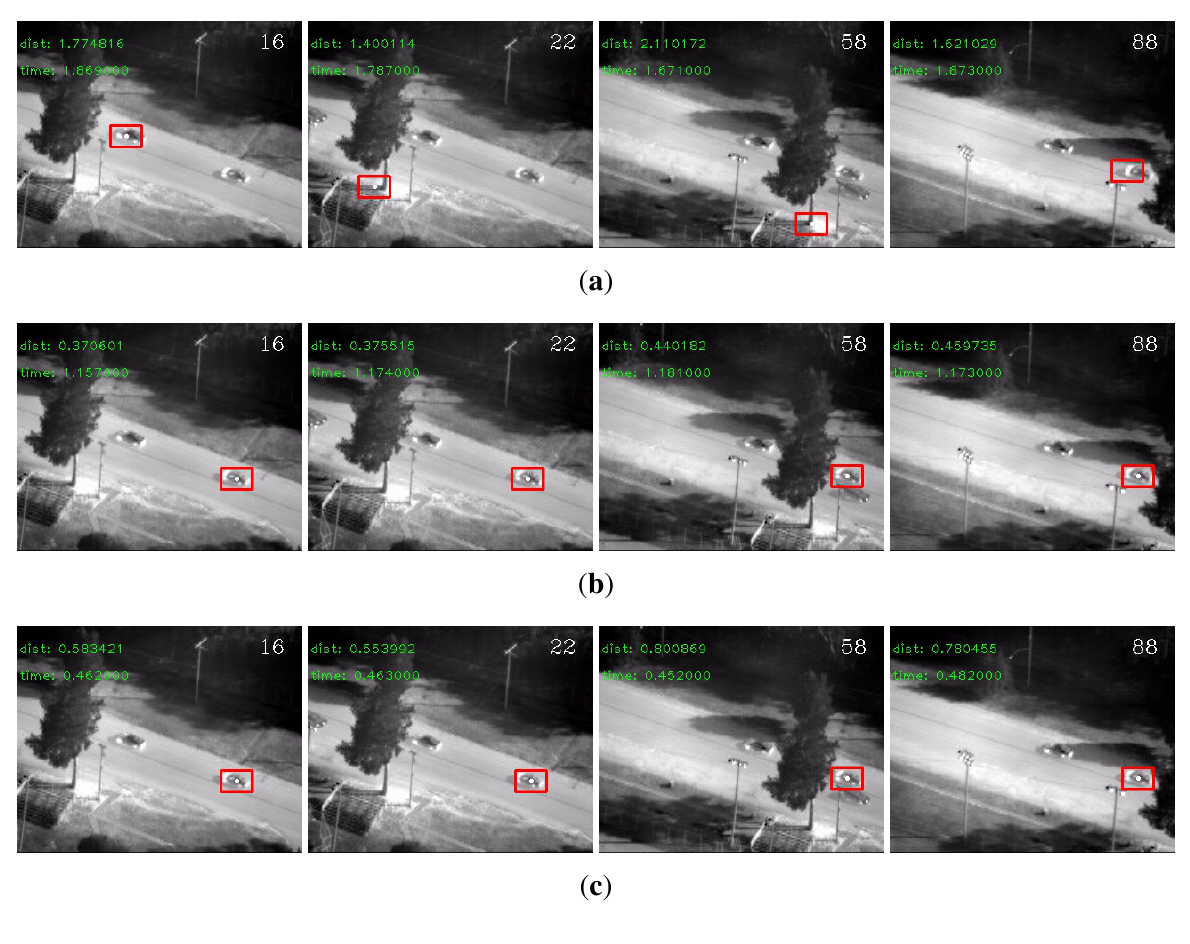
covariance descriptor, ( b ) using the regularized covariance descriptor and ( c ) using the adaptive covariance descriptor. The initial frame with the target marked in rectangle is shown in Figure